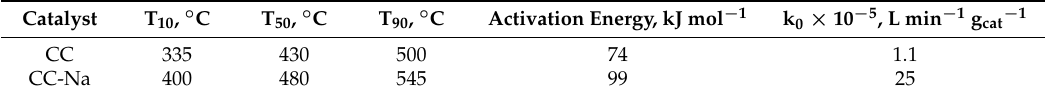
Table 3. Results from the kinetic analysis of activity results.